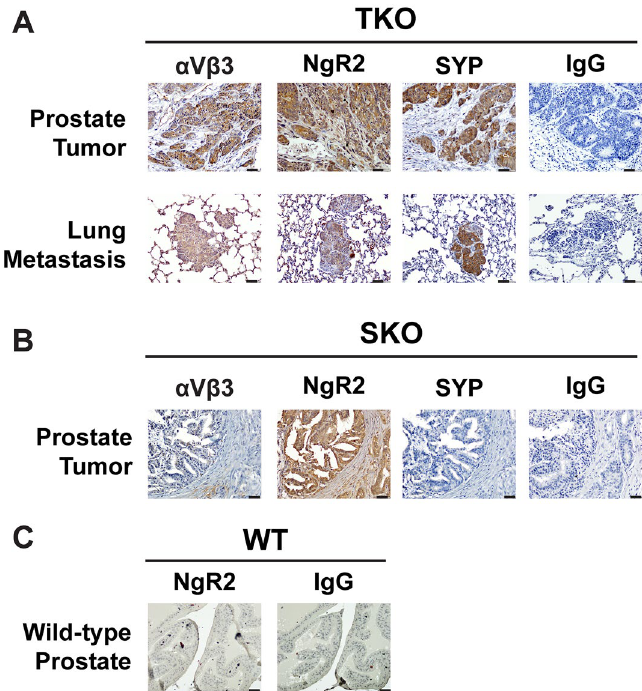
Figure 3. NgR2 expression is increased in NEPrCa TKO mouse tumors. ( A, B ) Representative immunohistochemical staining of the αVβ3 integrin, NgR2, and SYP of prostate tumors (top row) and lung metastasis (bottom row) from TKO mice ( A , n = 5) and of primary tumors from SKO mice ( B , n = 5). ( C ) Representative immunohistochemical staining of NgR2 of prostate samples from wild-type mice (n = 4). IgG was used as negative control ( A–C ). The bars at the bottom right corner of each panel represent 20